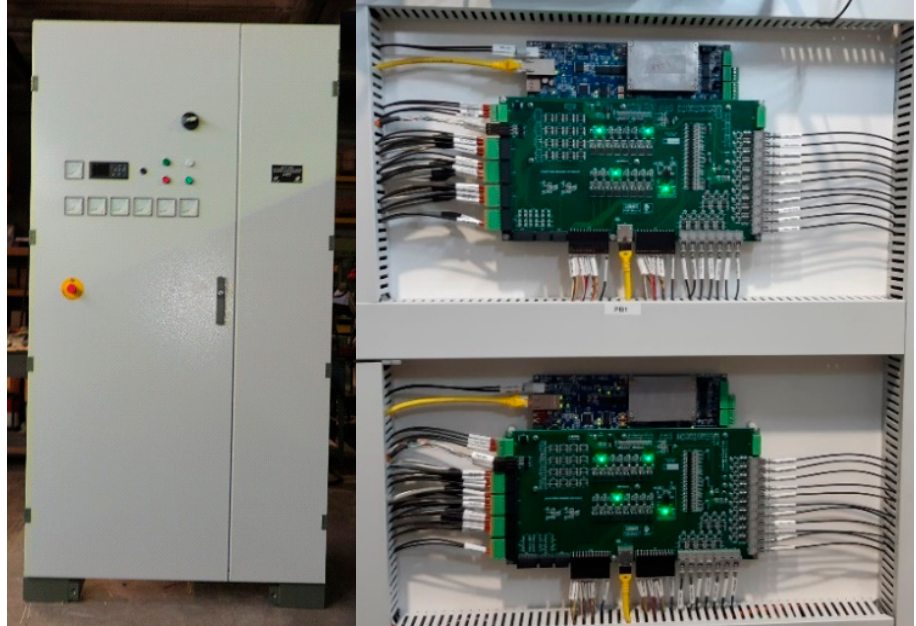
Figure 5. Charging station with integrated power electronics converters and control platforms.